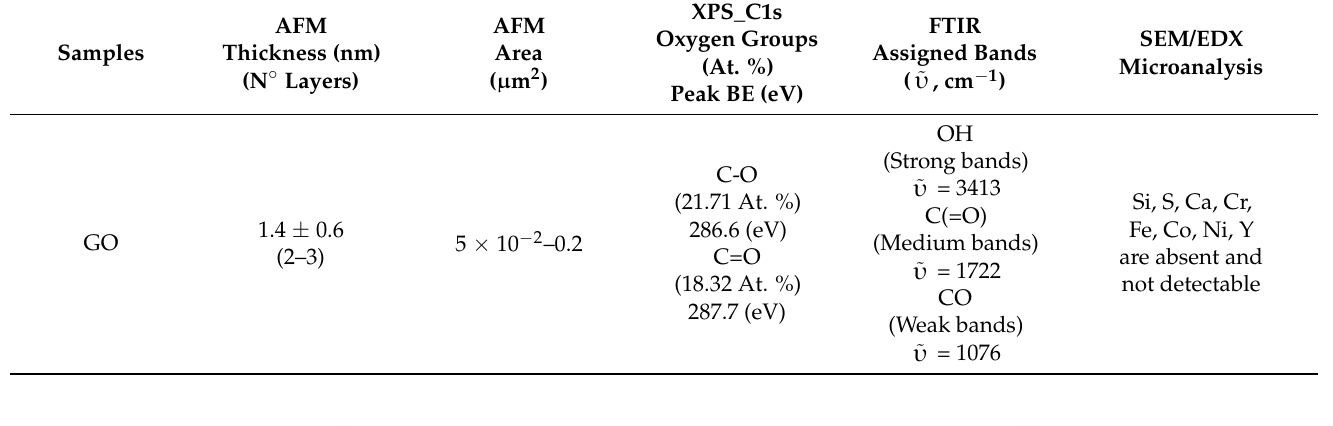
Table 1. Characterization of functionalized graphene oxide, GO.